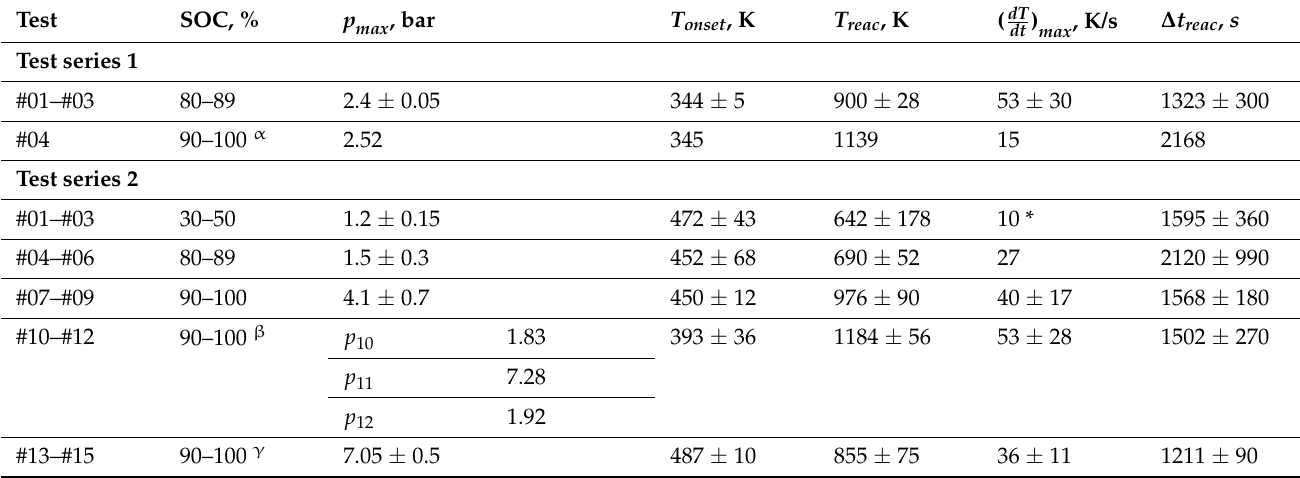
(cid:16) (cid:17) dT and ∆ t reac for the Series 1 and 2 dt max